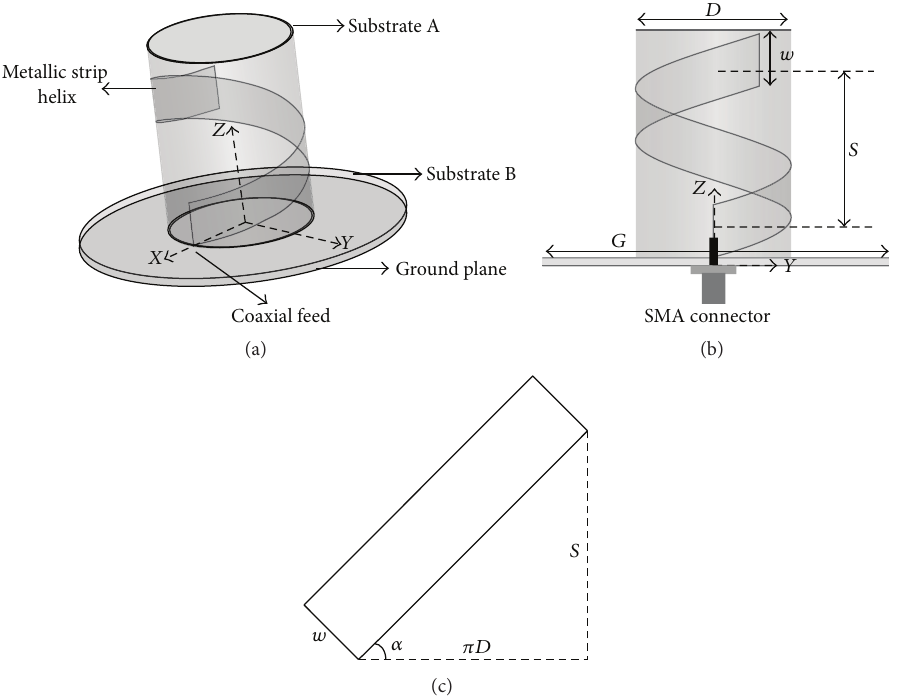
Figure 1: Geometry of the proposed strip-helical antenna. (a) 3D view. (b) Side view. (c) Unrolled strip helix of one